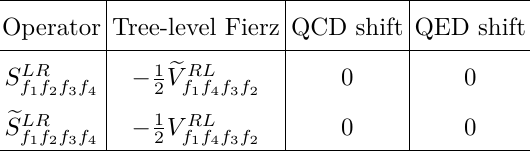
Table 4. Fierz transformations for scalar P L ⊗ P R operators together with their one-loop QCD and QED shifts in the original BMU